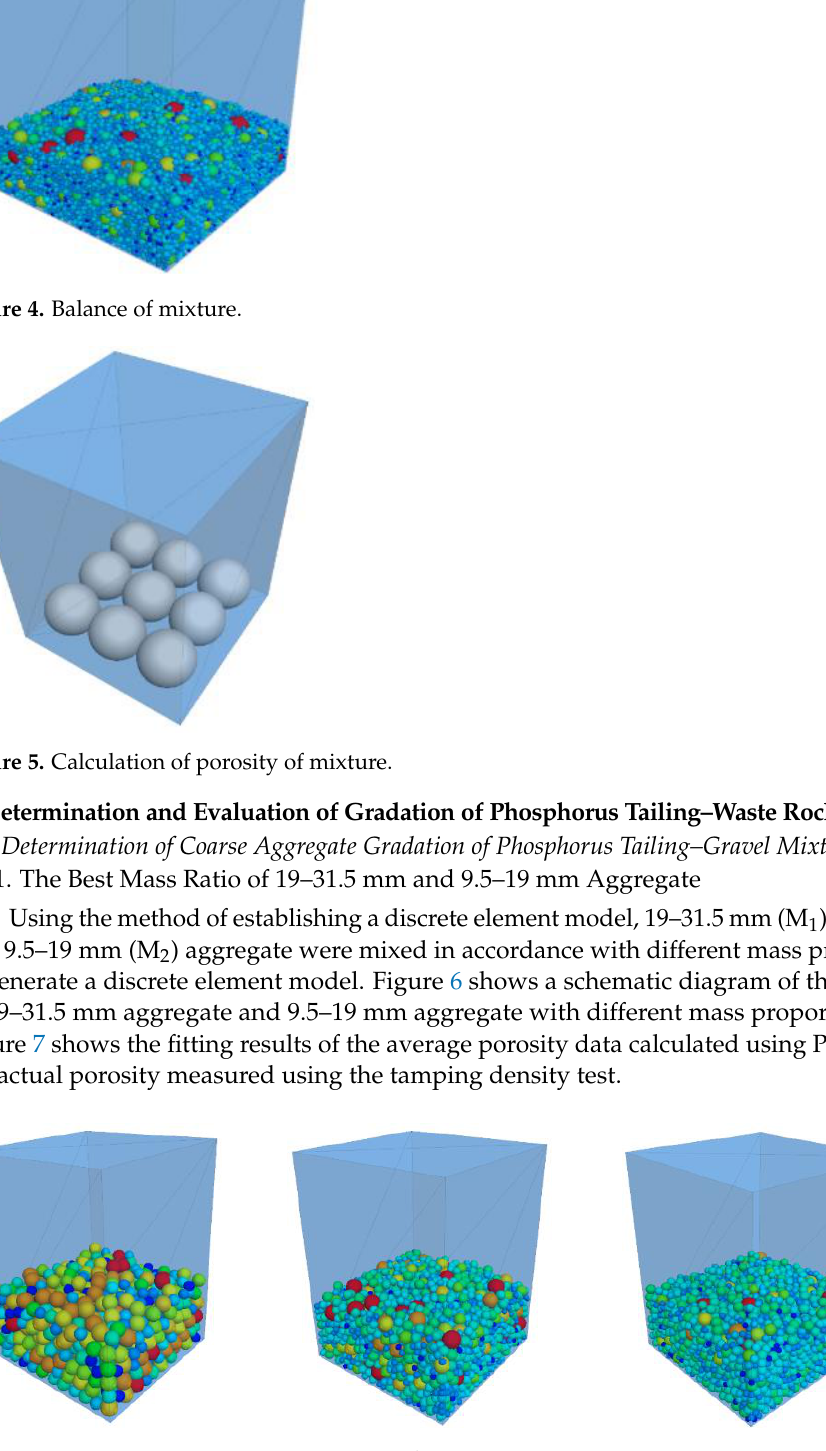
34.5035.00 Figure 7. Fitting results of 19 – 31.5 mm aggregate and 9.5 – 19 mm aggregate porosity in different mass proportions. 4.1.2. The Best Mass Ratio of 9.5 – 31.5 mm and 4.75 – 9.5 mm Aggregate On the basis of the optimal mass ratio of 19 – 31.5 mm aggregate and 9.5 – 19 mm ag- gregate, 4.75 – 9.5 mm aggregate was mixed into it in accordance with the different mass ratios to generate a discrete element model. Figure 8 shows the schematic diagram of the stacking of the 9.5 – 31.5 mm (M 1 + M 2 ) aggregate and 4.75 – 9.5 mm (M 3 ) aggregate with different mass proportions, and Figure 9 shows the fitting results of the average porosity data calculated using PFC3D and the actual porosity measured using the tamping test. ( a ) ( b ) ( c ) Figure 8. Schematic diagram of 9.5 – 31.5 mm aggregate and 4.75 – 9.5 mm aggregate in different mass ratios. ( a ) (M 1 + M 2 ):M 3 = 100:0, ( b ) (M 1 + M 2 ):M 3 = 70:30, ( c ) (M 1 + M 2 ):M 3 = 80:20. 33.50 34.00